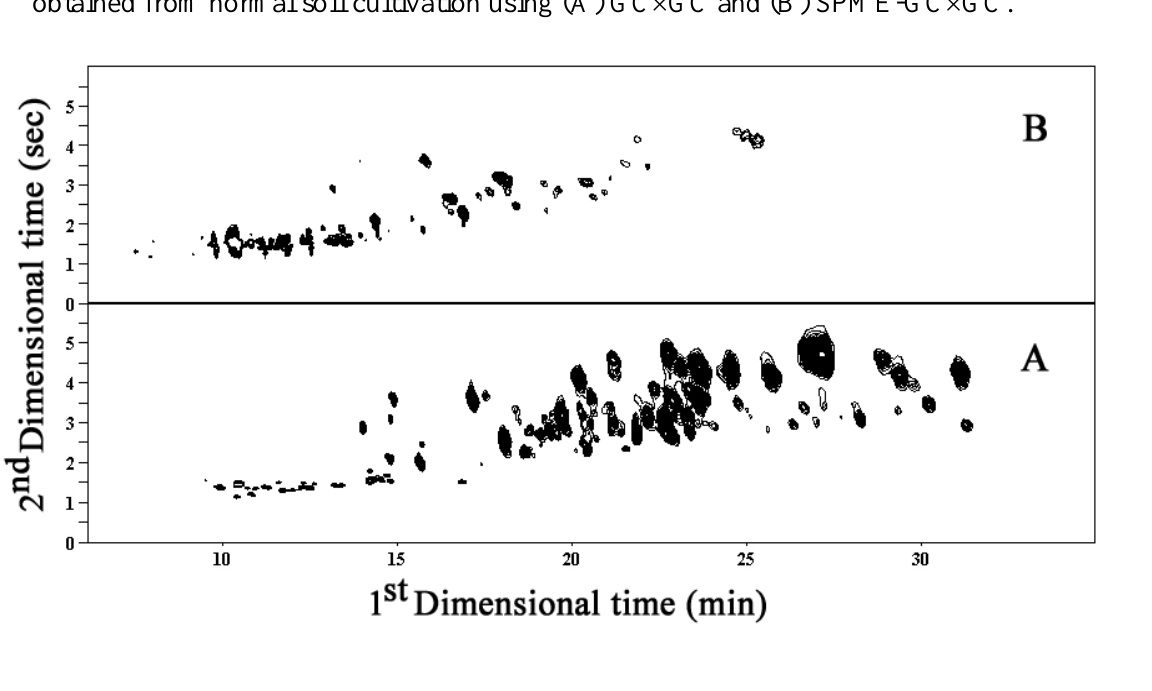
Figure 1. The contour plots of volatile component profiles of vetiver essential oils obtained from normal soil cultivation using (A) GC × GC and (B) SPME-GC ×